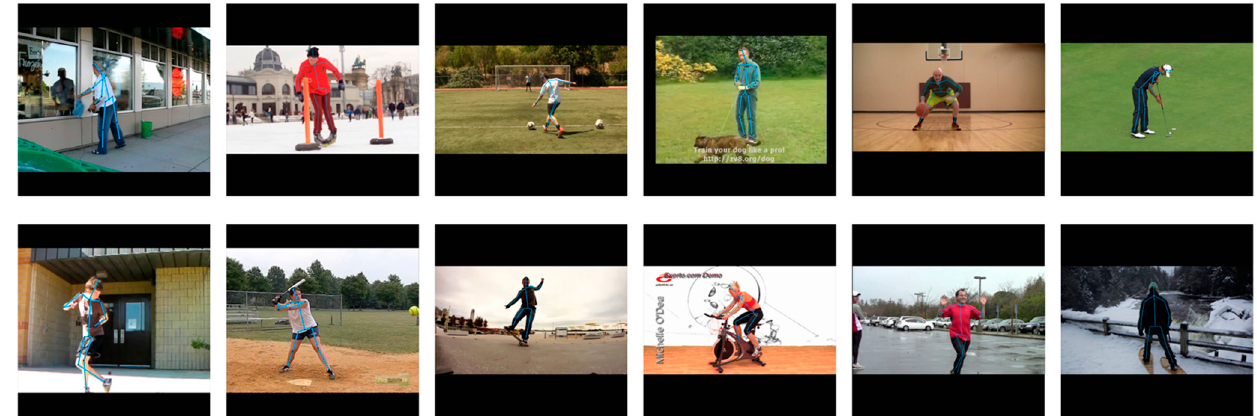
Figure 6. Qualitative results of 2D human pose on the MPII dataset.